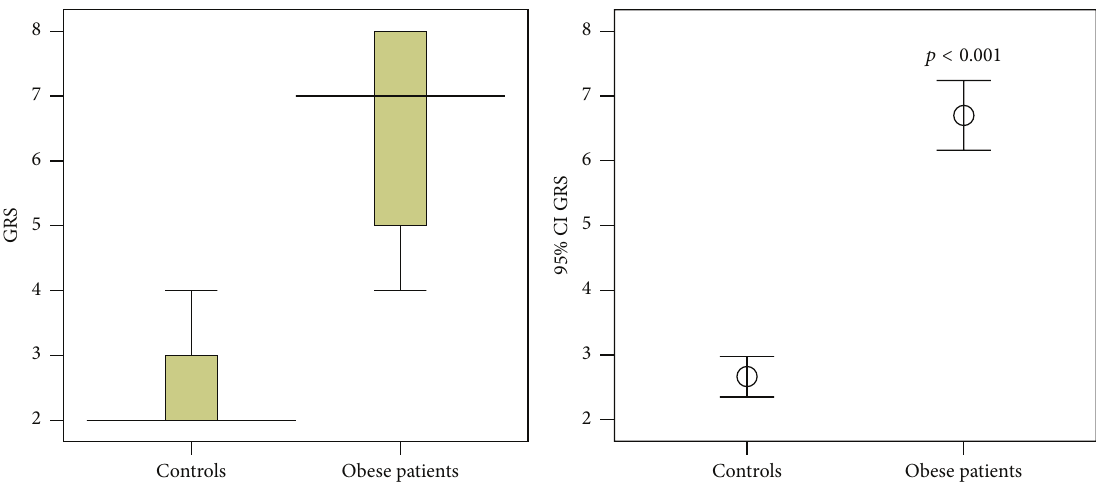
Figure 3: Results of gustatory response scores for the detection of fat in obese patients and controls. 𝑝 < 0.05 was considered statistically significant. Data are presented as mean ± standard error. CI: confidence interval and GRS: gustatory response score.